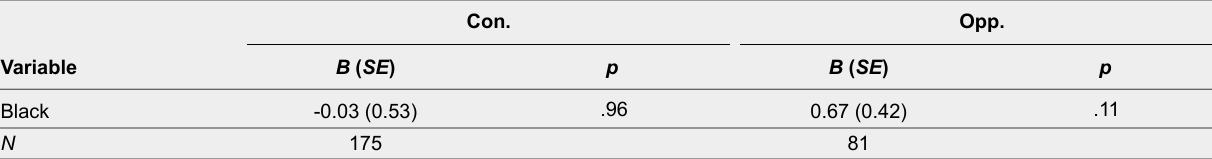
Logit Models Regressing Race on Participants' Reported Hope, Across Control and Opportunity Conditions Opp.Con.